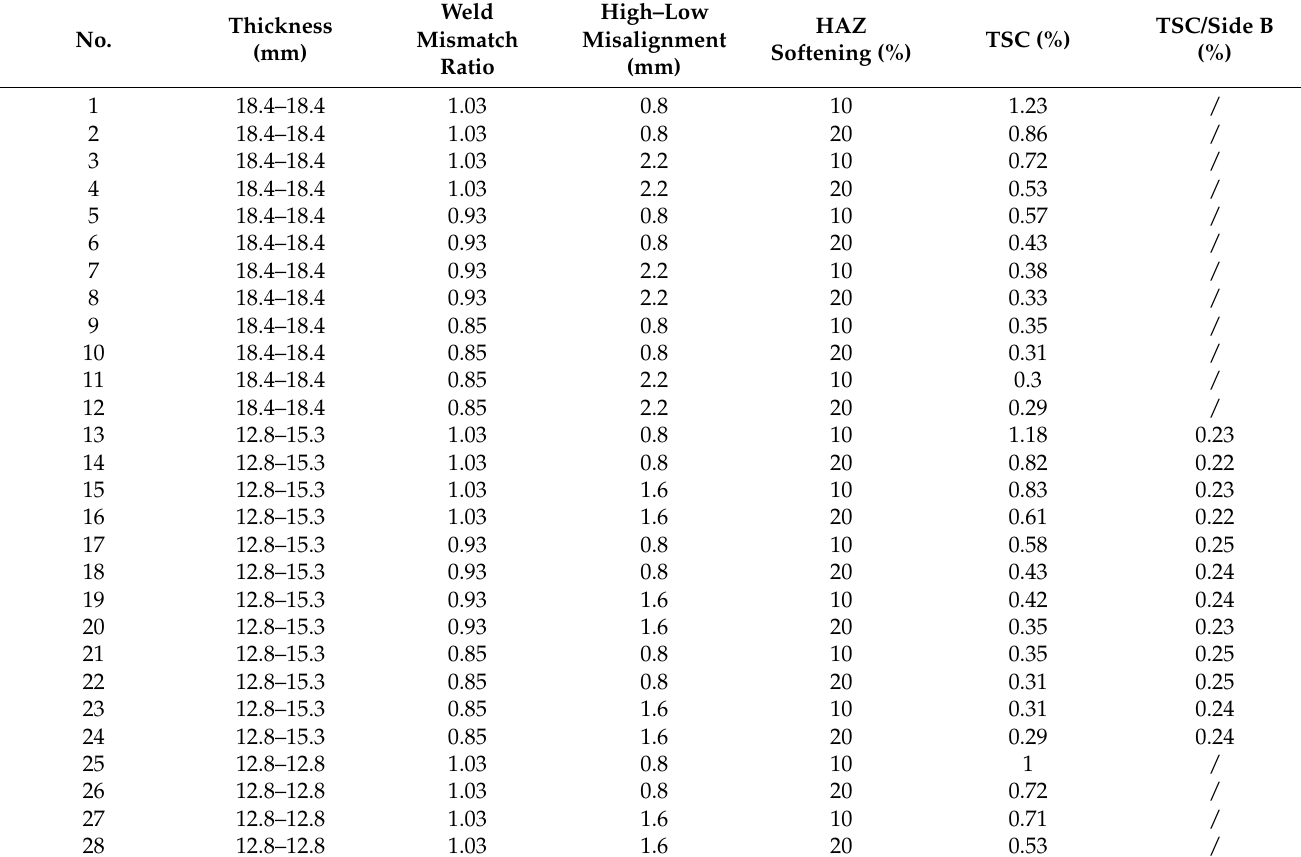
Table A1. Part of the TSC results (internal pressure = 5.6 MPa, CTODA = 0.45